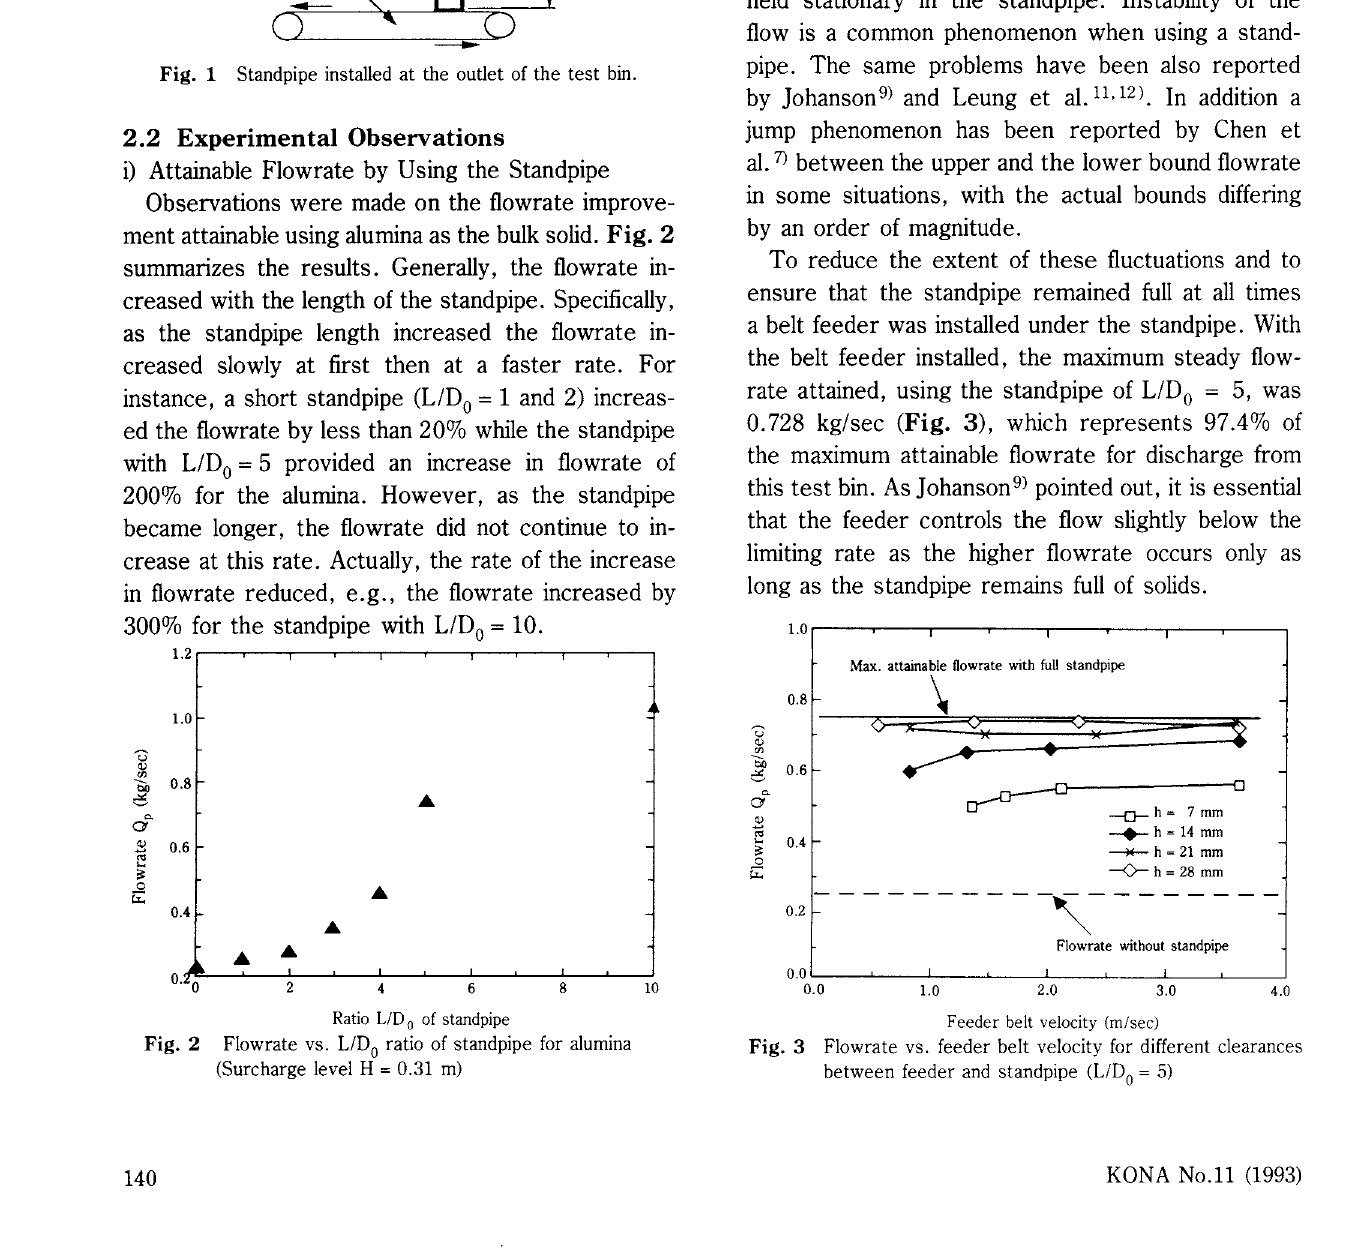
Fig. 1 Standpipe installed at the outlet of the test bin.